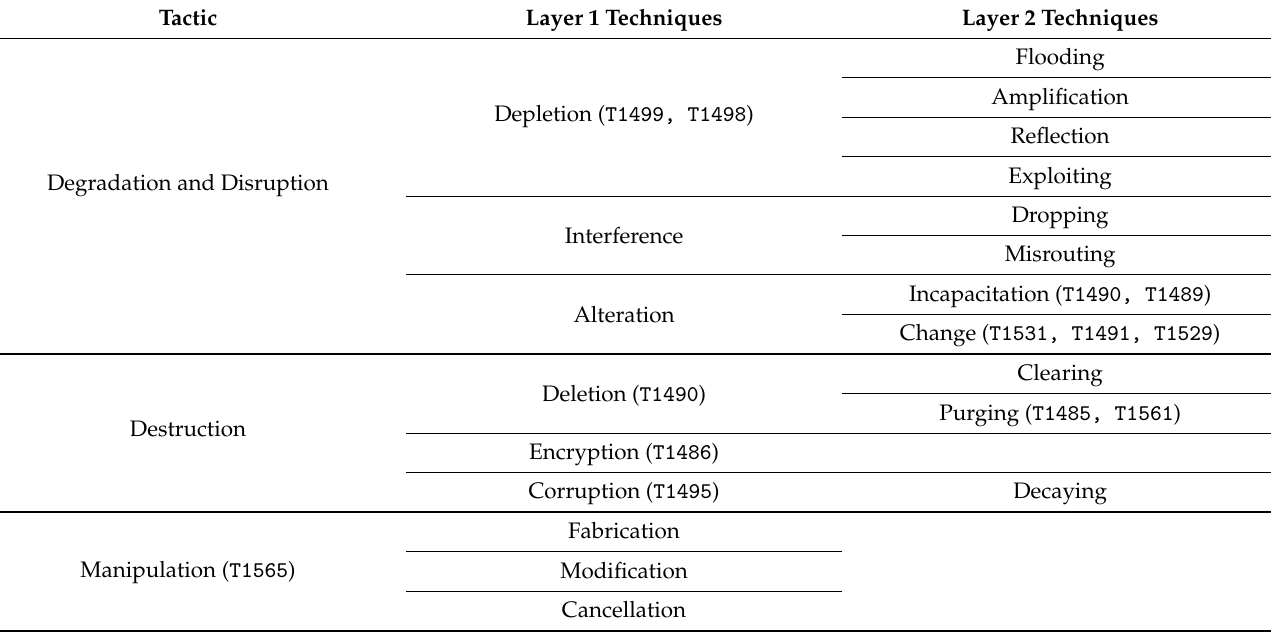
Table 6. MITRE ATT&CK techniques